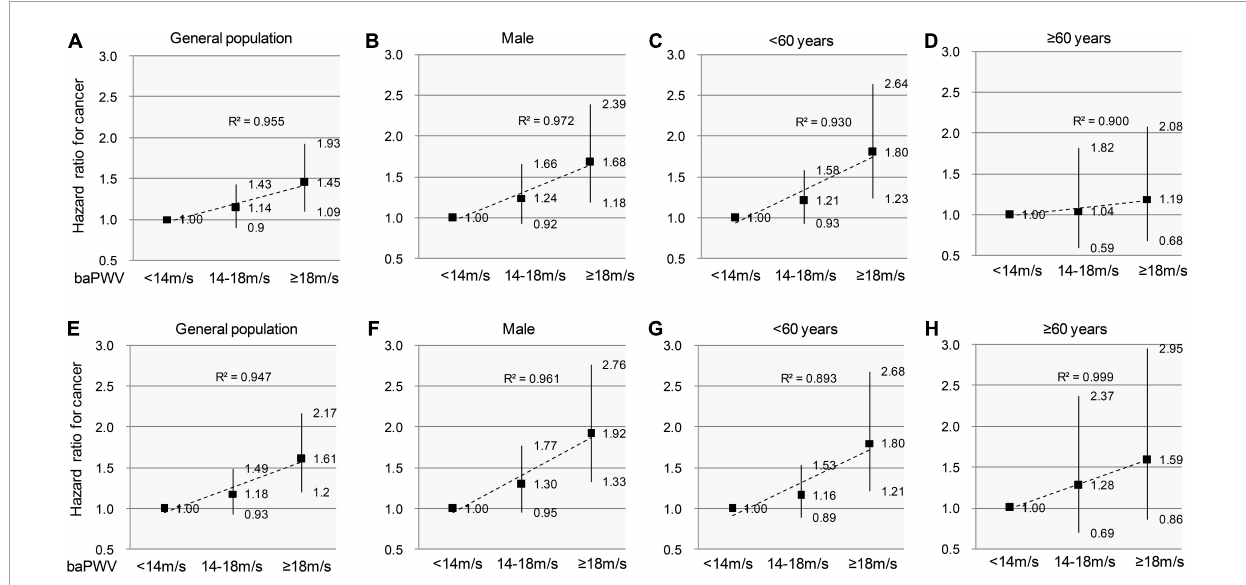
FIGURE5 Sensitivity analyses to test the association between arterial stiffness and incident cancer in individuals without PAD/CVDs. Participants are categorized into 3 groups according to baPWV values. The sign of PAD is defined as ABI ≤ 0.9 and/or IAD ≥ 15 mmHg. The hazard ratios and 95% confidence intervals for cancer incidence remain essentially unchanged after excluding the individuals with PAD/CVDs in the entire cohort (A,E) , men (B,F) , individuals < 60-year-old (C,G) , and individuals ≥ 60-year-old (D,H) . The dashed trend lines fit HRs well and R 2 show a linearly increasing risk for cancer incidence. PAD, Peripheral arterial disease; CVDs, cardiovascular diseases; baPWV, brachial-ankle pulse wave